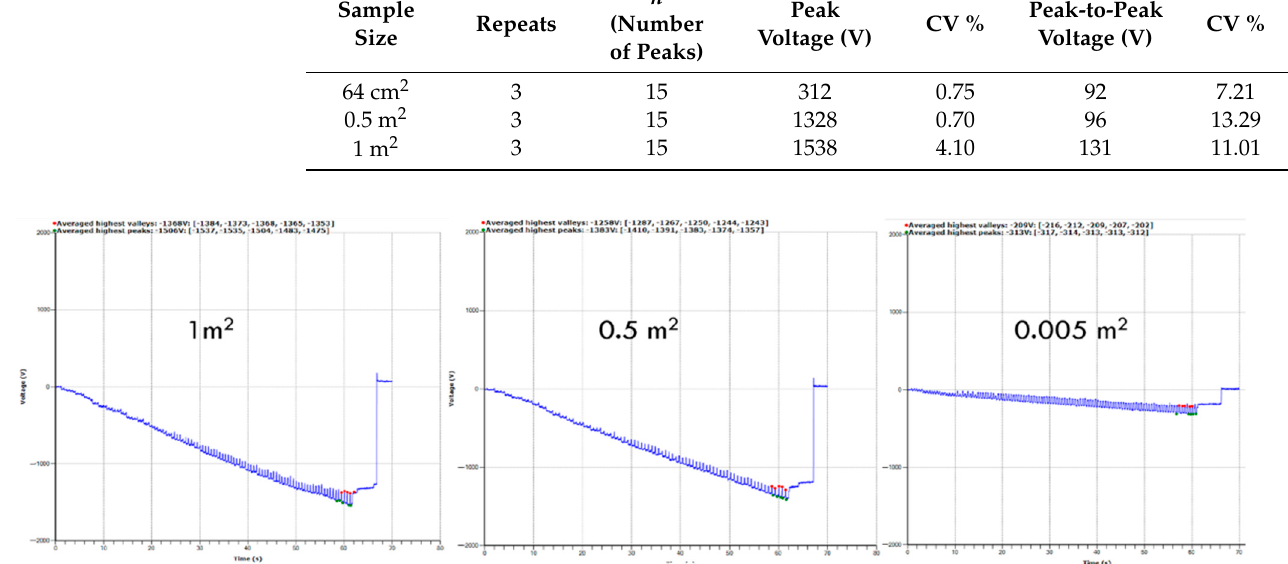
Figure 12. Effect of different sample size on the electrostatic waveform.